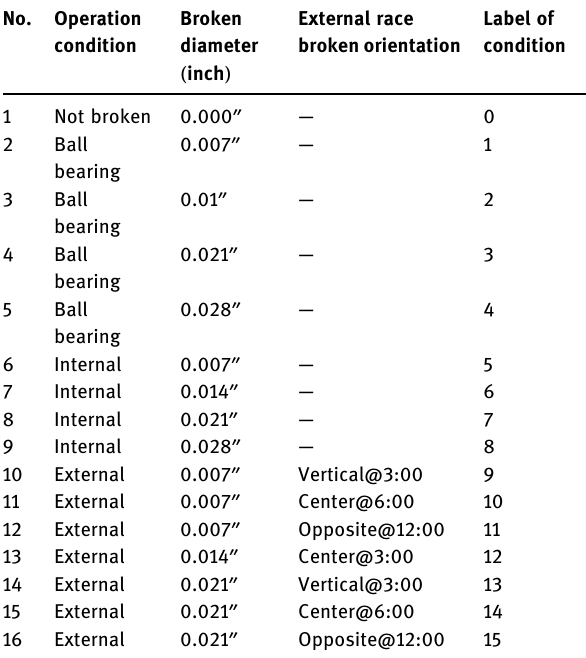
Table 2: Operation conditions of bearing No.